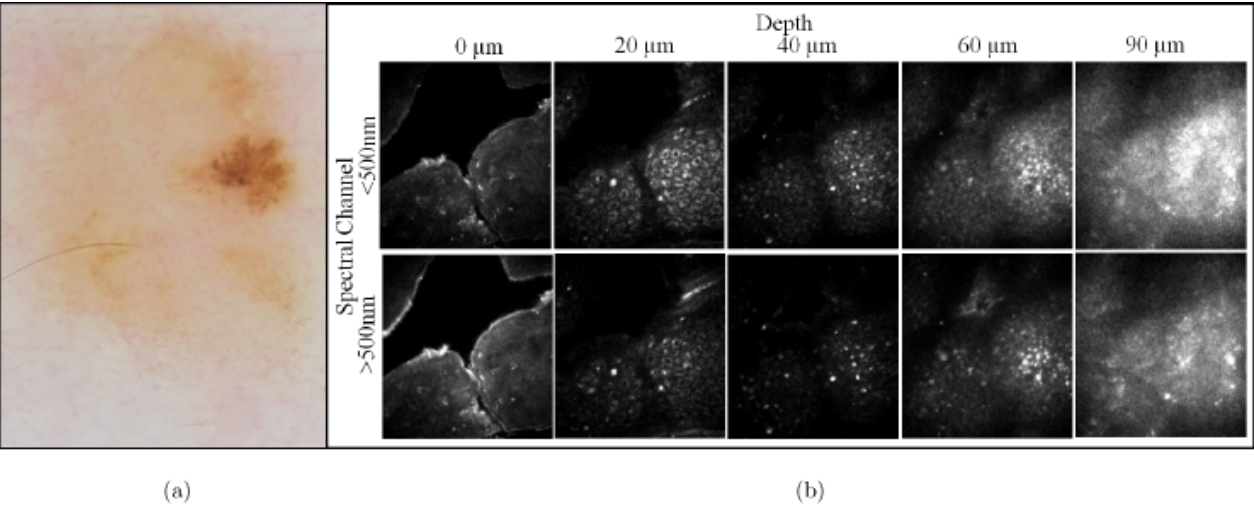
Fig. 2. (a) Nevus, (b) Fluorescence lifetime images at di®erent depths, imaging ¯eld of view 177 (cid:1) 177 (cid:1) m 2 . 24 (Permission has been granted by \SPIE".)